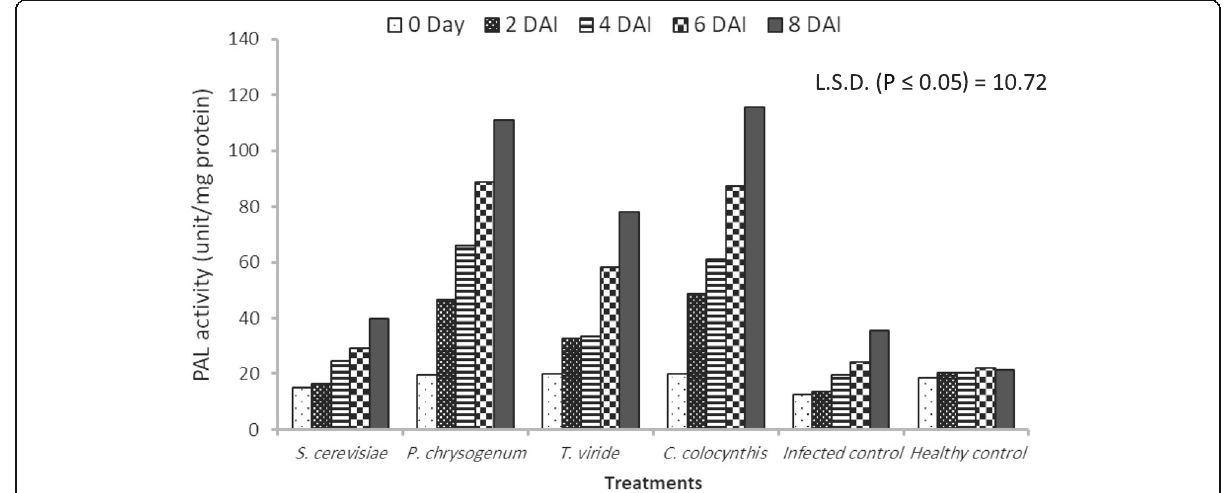
Fig. 5 Effect of application of bioagents and plant extract phenylalanine ammonia-lyase (PAL) activity in onion